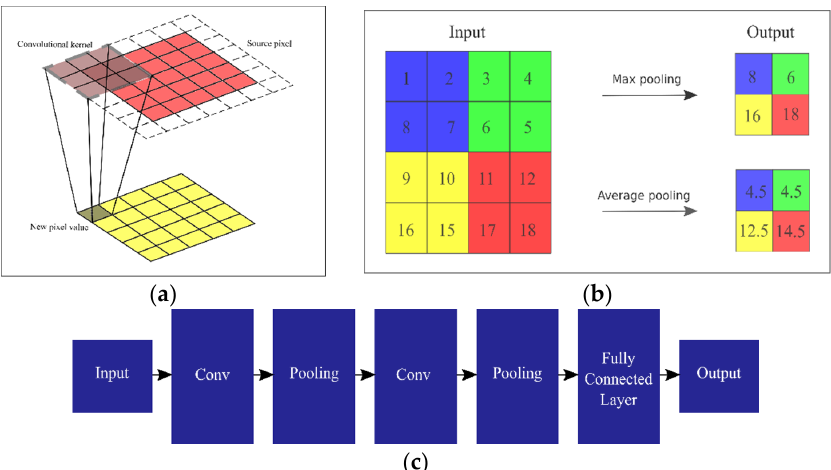
Figure 3. Deep convolutional neural network training architecture. ( a ) Description of convolutional process using kernel on two-dimensional input source; ( b ) Description of maximum and average pooling process; ( c ) Basic deep Convolutional Neural Network (CNN) structure typically consisting of multiple convolutional and pooling layers with a fully connected layer at the end before output.